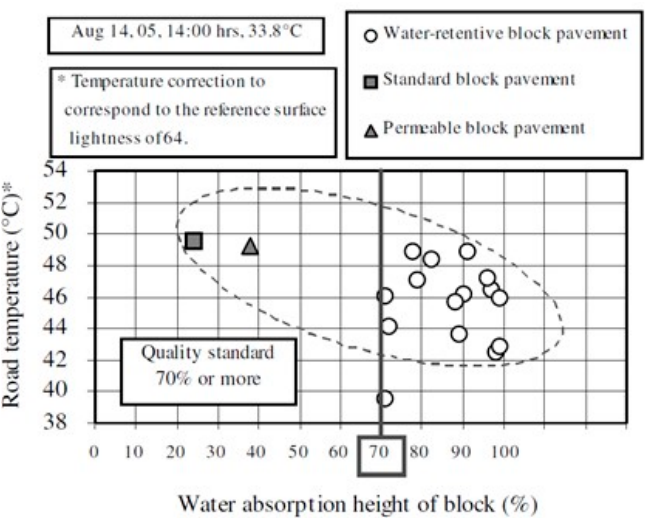
Figure 12. Relation between evaporation rate from the surface and road surface temperature on the day after spraying [130].